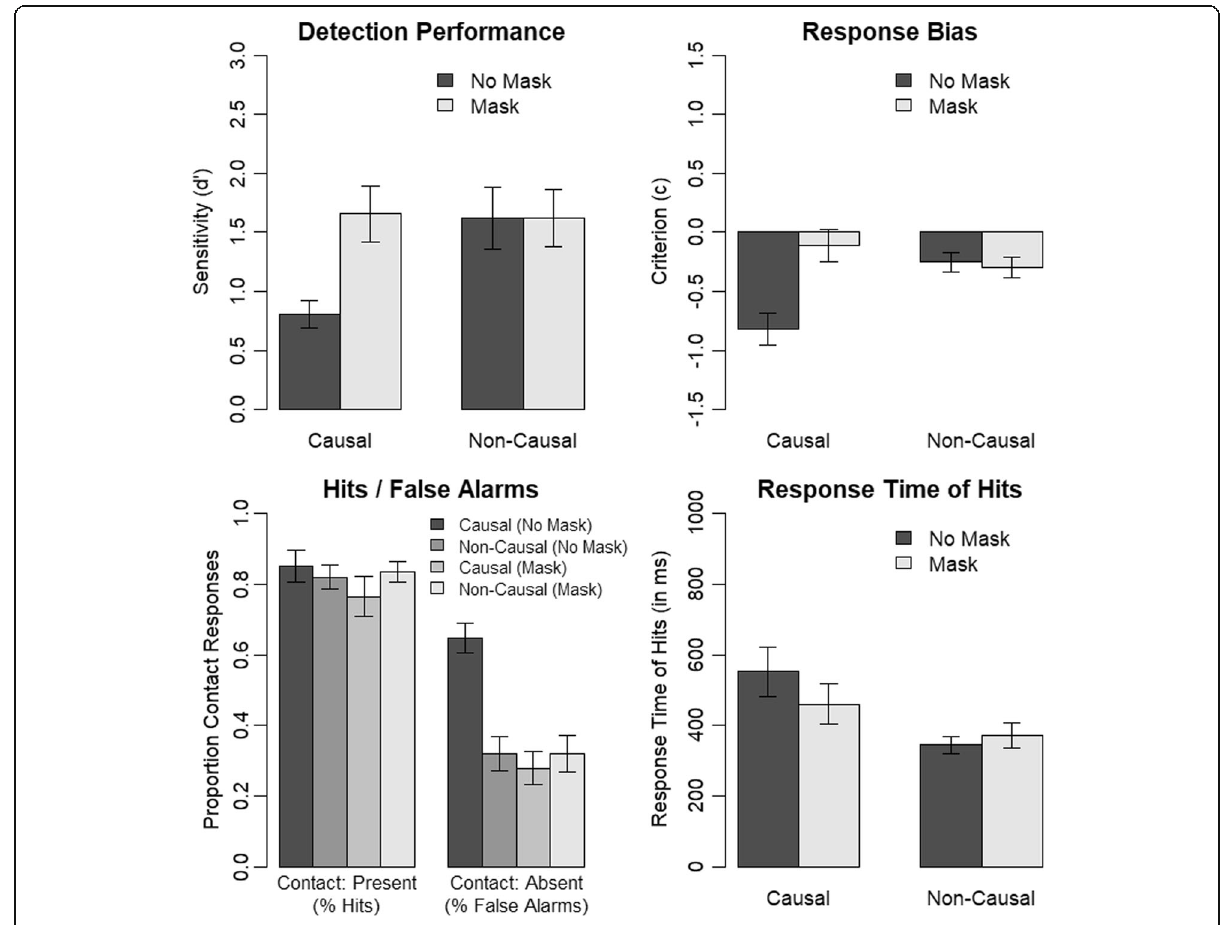
Fig. 4 Results of Experiment 2. Error bars indicate the standard error of the